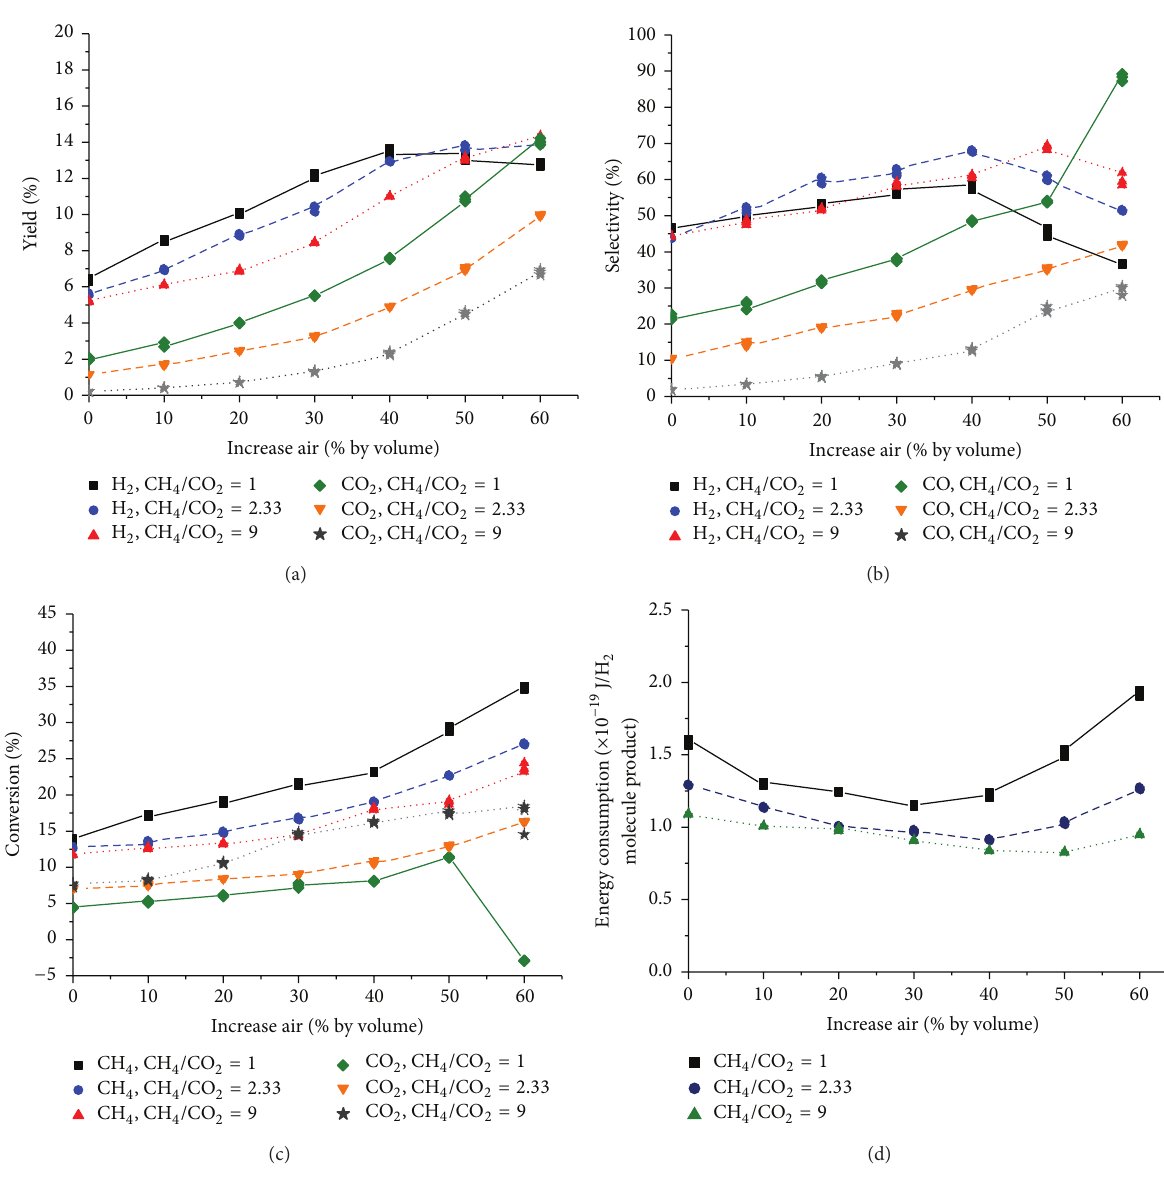
Figure 4: Effect of air addition on biogas reforming